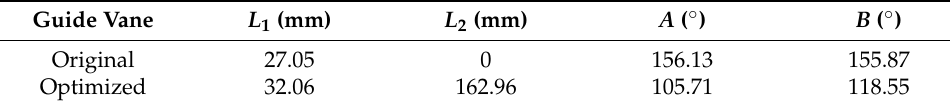
Table 4. Comparison of parameters before and after optimization. Guide